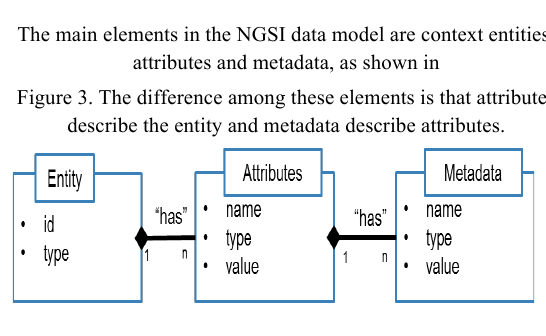
Figure 3 Elements of the NGSI data